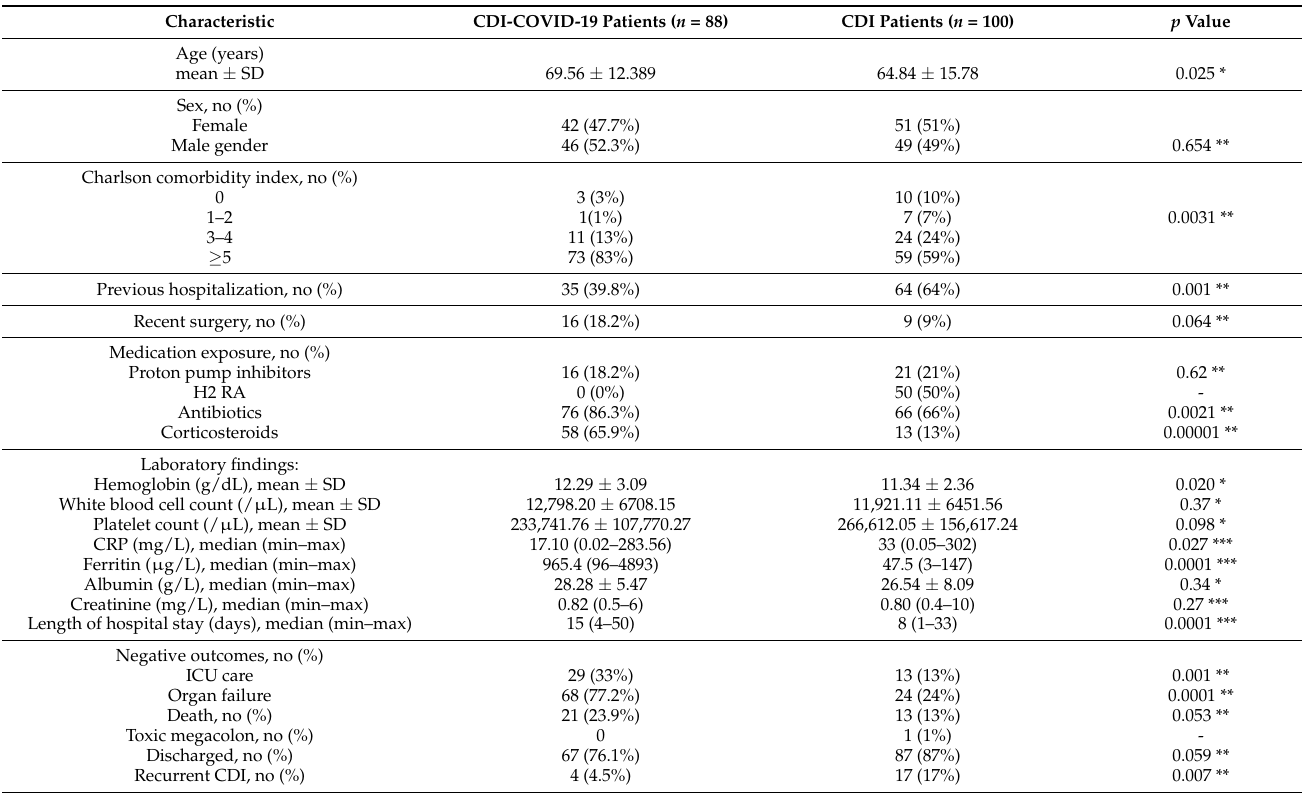
Table 1. Patient characteristics in both